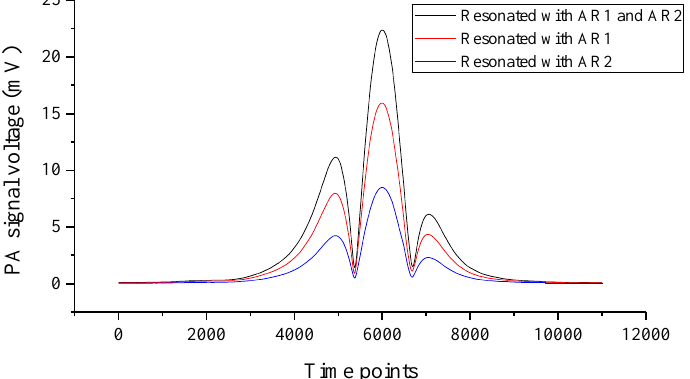
Figure 3. PA signals in different resonant cases; the black line represents the total PA signal resonated by combination of AR1 and AR2; the red line denotes the PA signal only resonated by AR1; the blue line is the PA signal only resonated by AR2.